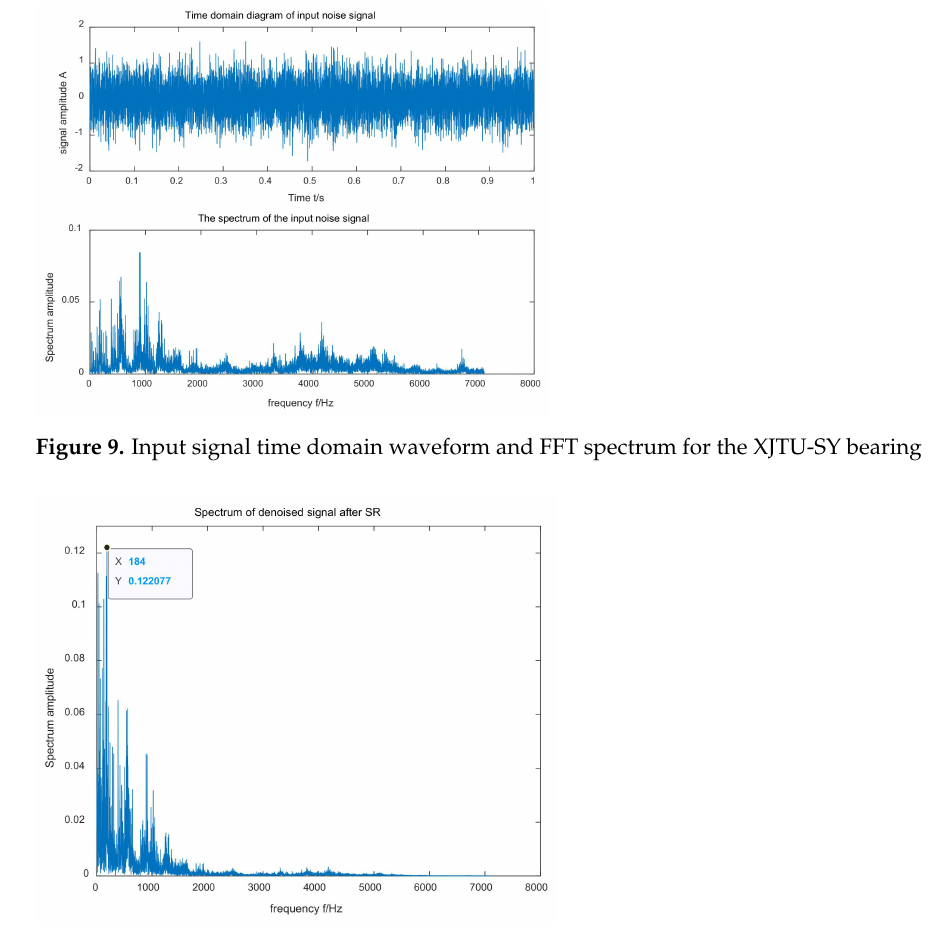
Figure 10. The output signal processed by the mentioned method for the XJTU-SY bearing